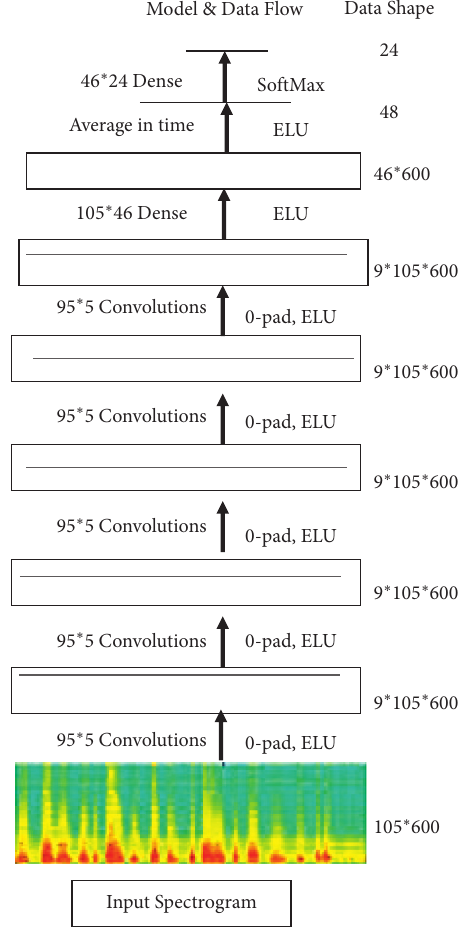
Figure 5: Conventional neural network for musical key